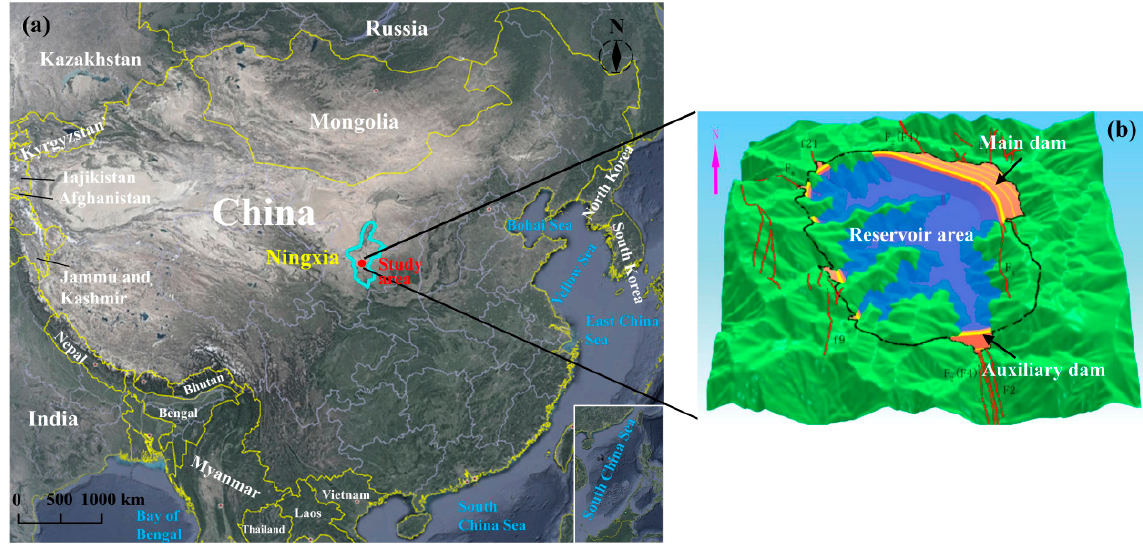
Figure 1. ( a ) Geographical location map; ( b ) layout of the reservoir site.